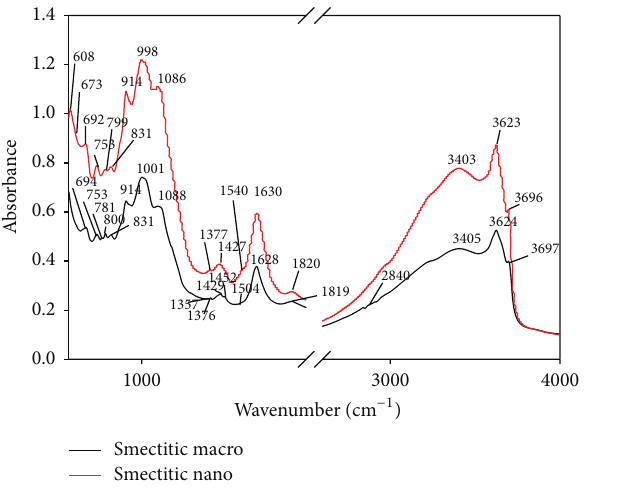
Figure 8: Kaolinitic nano- and macrocolloid FTIR characterization.